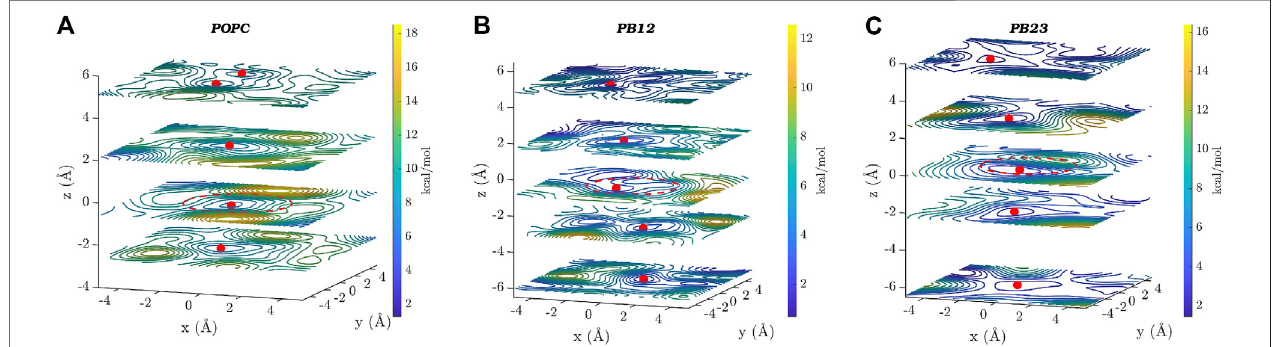
FIGURE4| Twodimensional( x – y )projectionsofthe3Dfreeenergy surfaceofwatertransportareshown atdifferent z -valuesforeachofthethreemembranes: (A) POPC, (B) PB 12 PEO 9 , and (C) PB 23 PEO 16 . Several free-energy minima are marked with a red point on two-dimensional projections of the free energy surface. A red circle with a dotted line is drawn to indicate the approximate size and the location of the central ring of the PAP channel. The free-energy scale is indicated by the color palette.